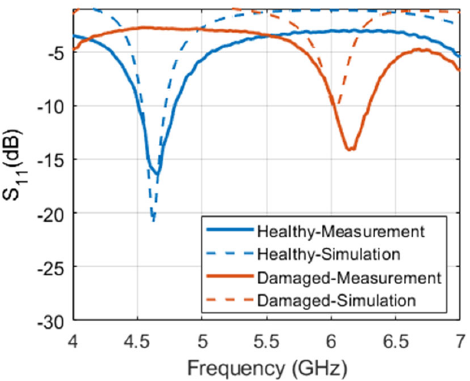
Figure 7. Measured magnitude of reflection coefficient of the patch antenna before and after inflicting damage.